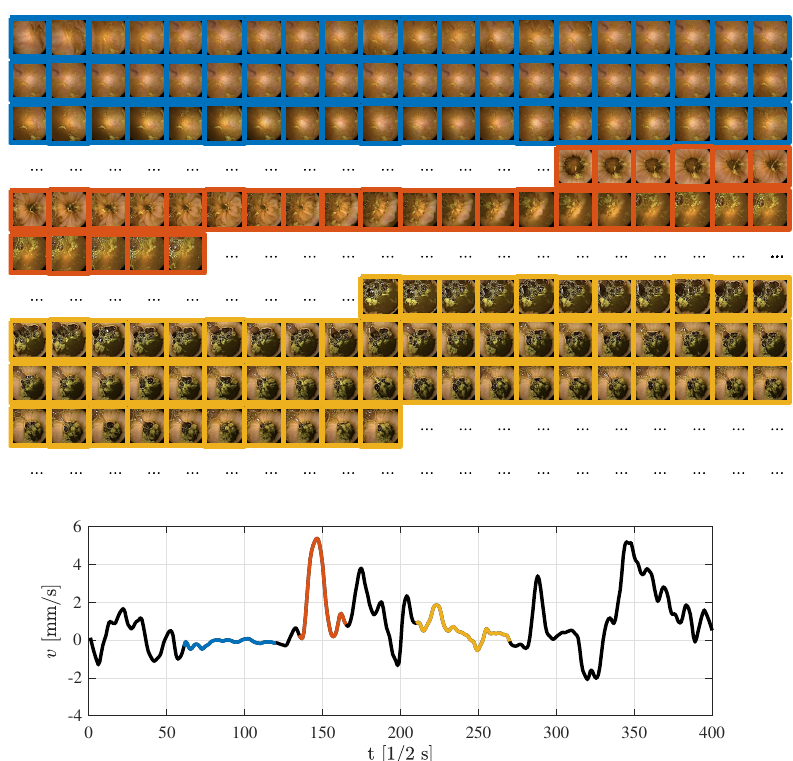
Figure 4. Selected examples of speed estimations based on a fixed sample frequency of 2 Hz and corresponding